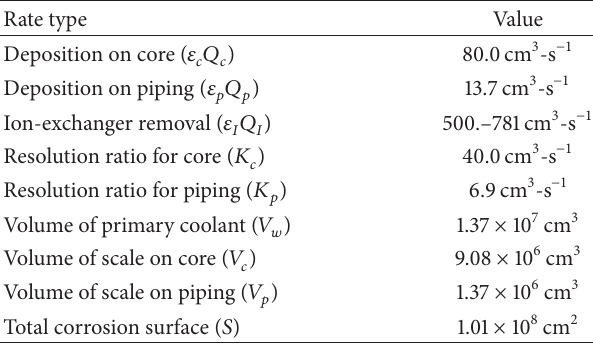
Table 2: Experimental values of exchange rates in a typical PWR [13–15, 34].